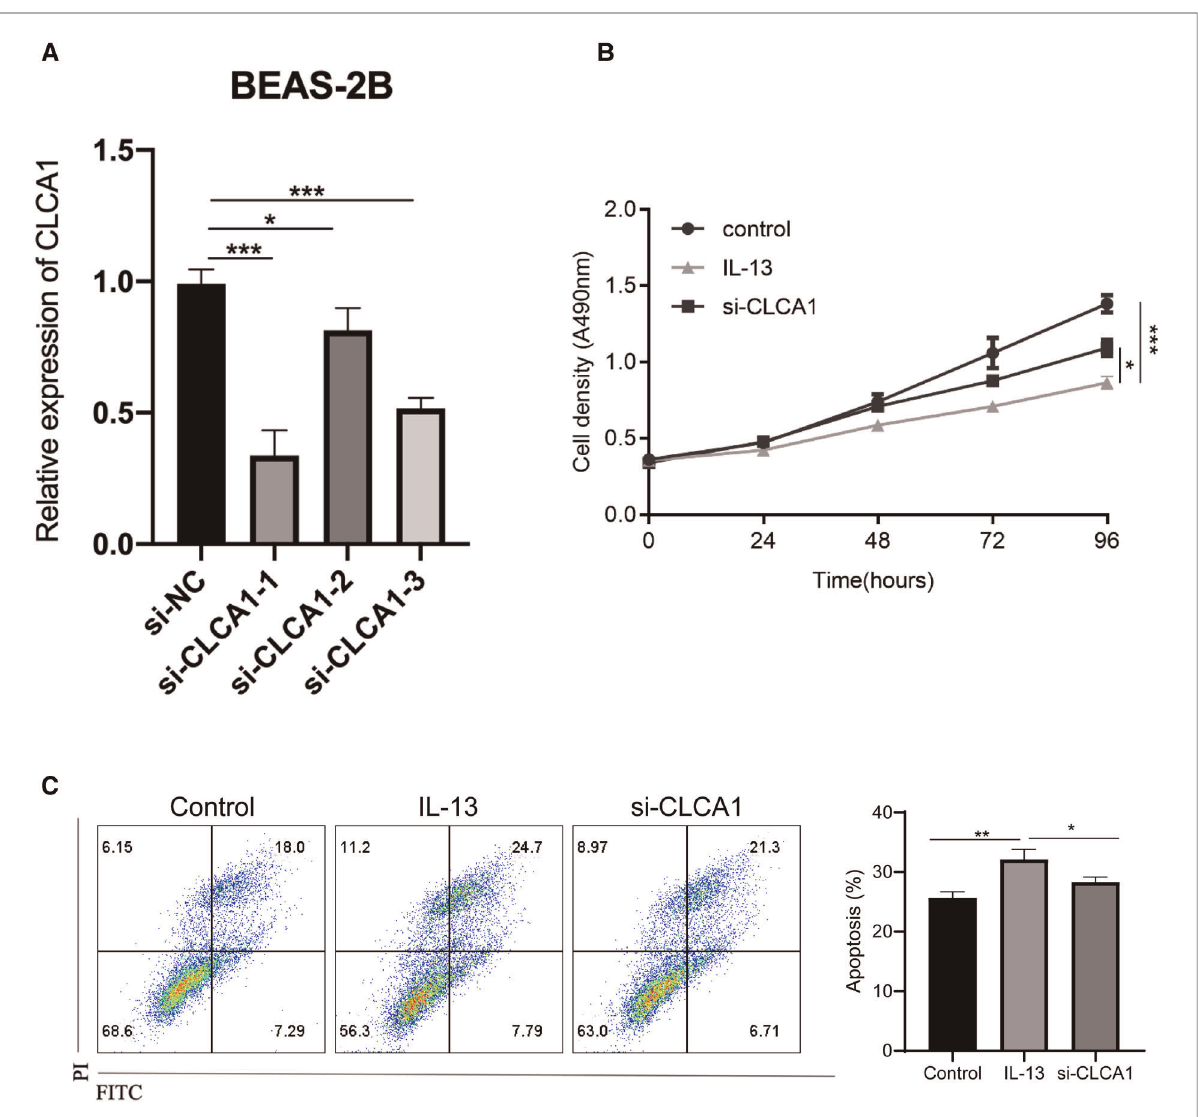
FIGURE 6 Knockdown of CLCA1 attenuates IL-13-induced bronchial epithelial cell activity and reduces cell apoptosis. CLCA1 knocked down BEAS-2B cells were stimulated with IL-13 and their ( A,B ) cell proliferation ability was assessed using the CCK-8 assay. ( C ) Flow cytometry was used to detect apoptotic cells.* p <0.05,*** p